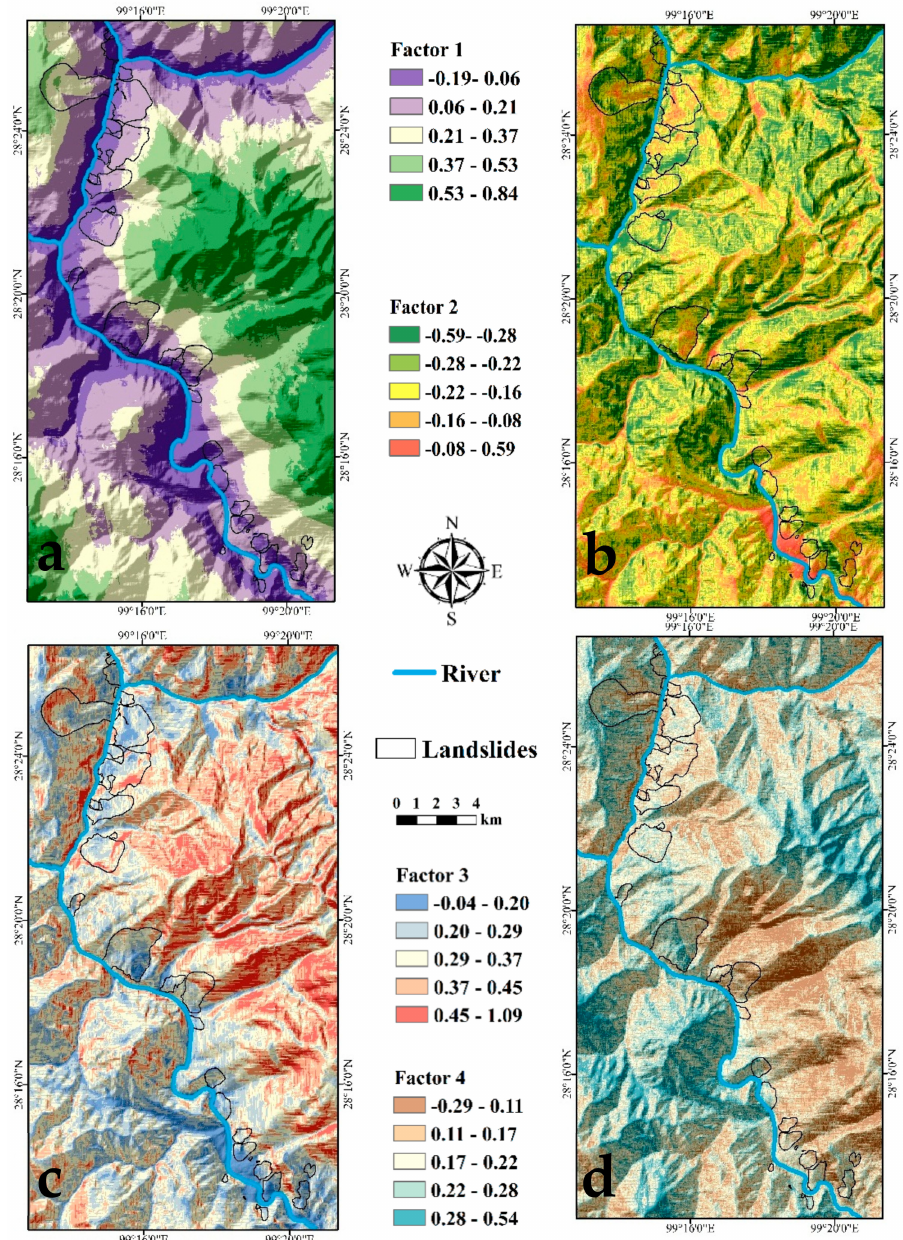
Figure 8. Influencing factor maps selected using principal component analysis (PCA): ( a ) Factor 1; (2) Factor 2; (3) Factor 3; and ( b ) Factor